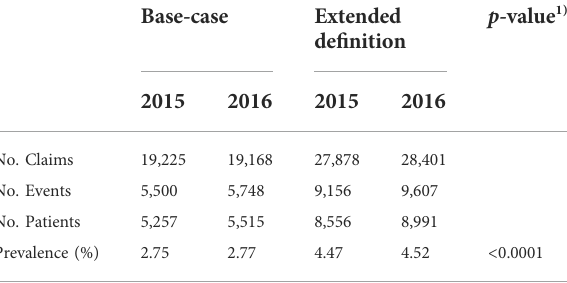
TABLE 4 Prevalence of adverse drug events by de fi nition study population.